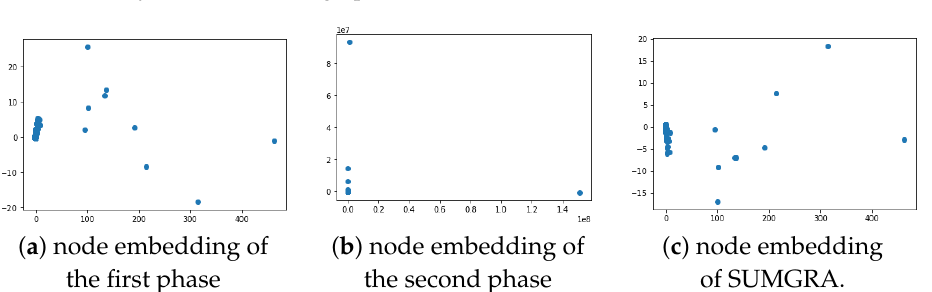
Figure 14. Query time on random graph2 dataset.